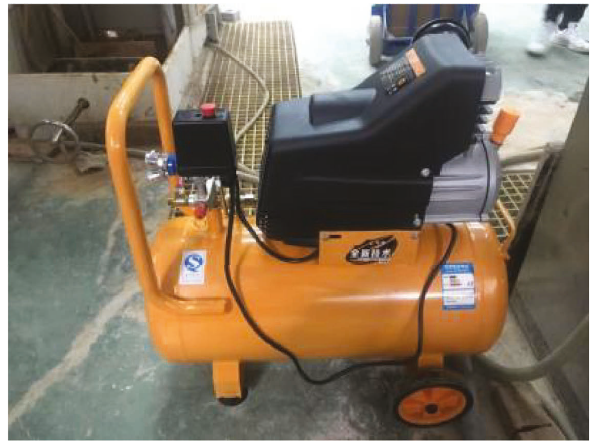
Figure 2: High-pressure air pump.